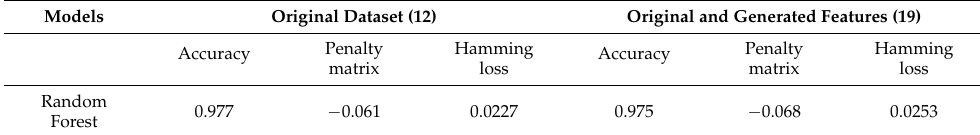
Table 8. Comparison three scores of Random Forest Classifier for the test dataset.